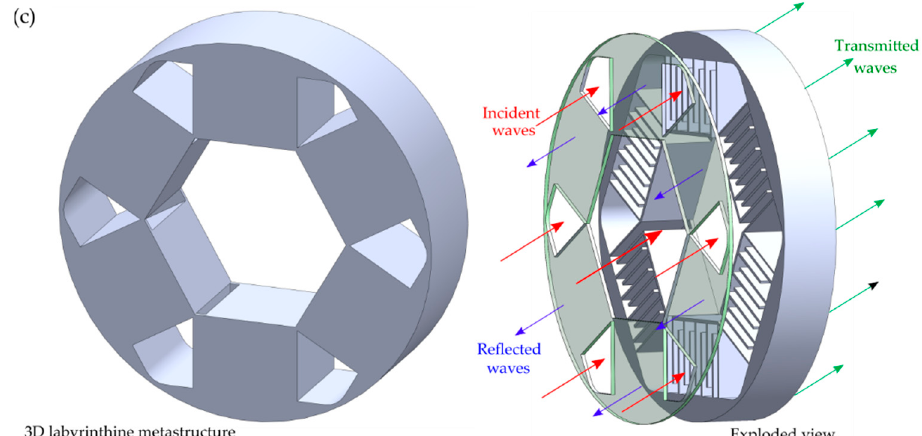
Figure 1. Potential designs for noise barriers with the air ventilation system: ( a ) perspective schematic of the ventilated metamaterial absorbers units arranged in a rectangular lattice. Reproduced with permission from Xiang et al. [77], Ultra-open ventilated metamaterial absorbers for sound-silencing applications in environment with free air flows ; published by Extrem. Mech. Lett ., © 2020 Elsevier Ltd.; ( b ) ventilated window panels. Reproduced with permission from Kumar et al. [70], Ventilated acoustic metamaterial window panels for simultaneous noise shielding and air circulation .; published by Appl. Acoust ., ©2020 Elsevier Ltd.; ( c ) ventilated labyrinthine acoustic metamaterial unit cell. Reproduced with permission from Kumar et al. [71], Labyrinthine acoustic metastructures enabling broadband sound absorption and ventilation ; published by Appl. Phys. Lett ., ©2020 AIP Publishing LLC. Each design structure is comprised of a sound absorption system and provision for allowing fluid flows, such as air or water, unrestricted passing through the sample.